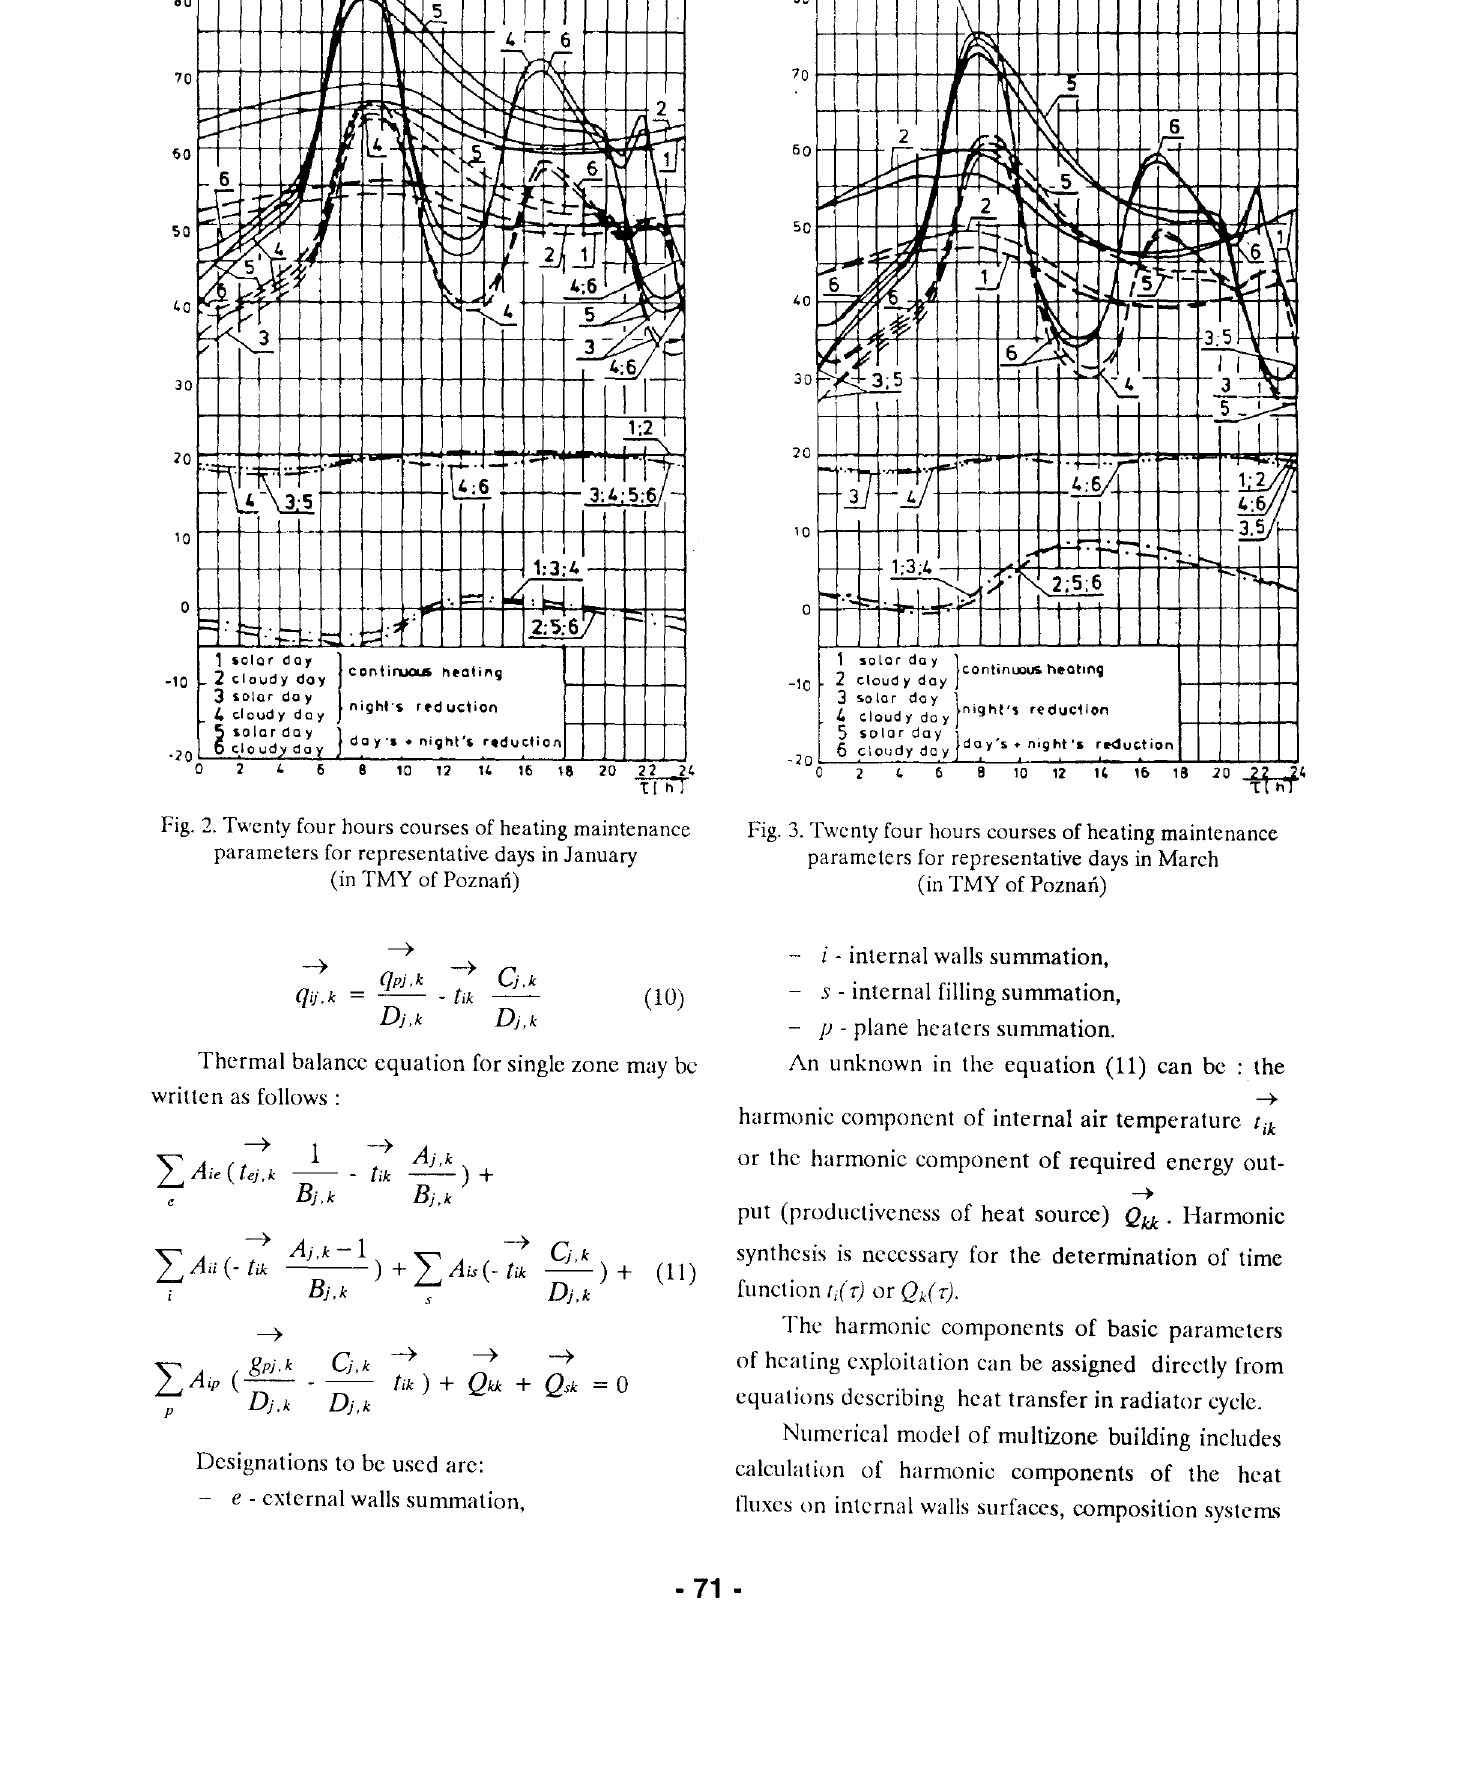
Fig. 2. Twenty four hours courses of heating maintenance parameters for representative days in January